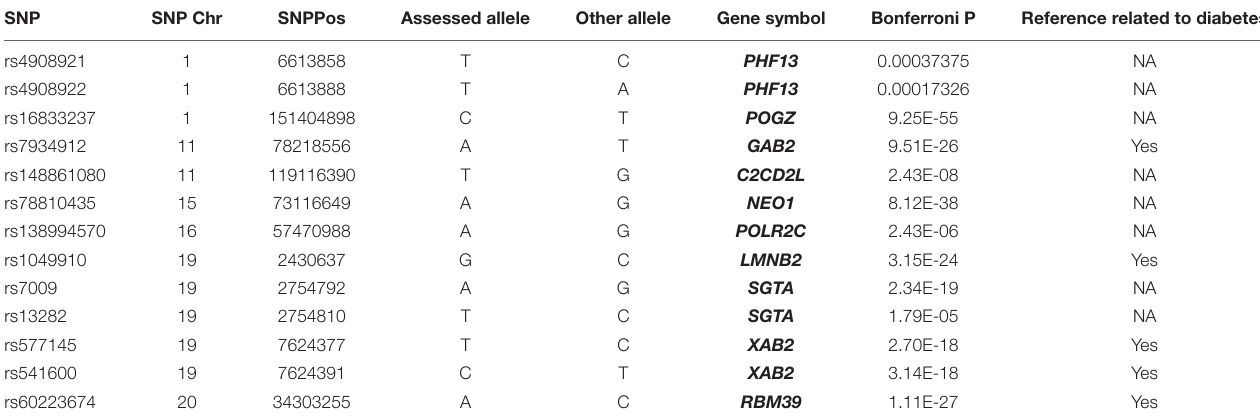
TABLE 2 | eQTL localized in the m 6 A peaks of genes co-expressed with m 6 A regulators. SNP SNPPos Assessed